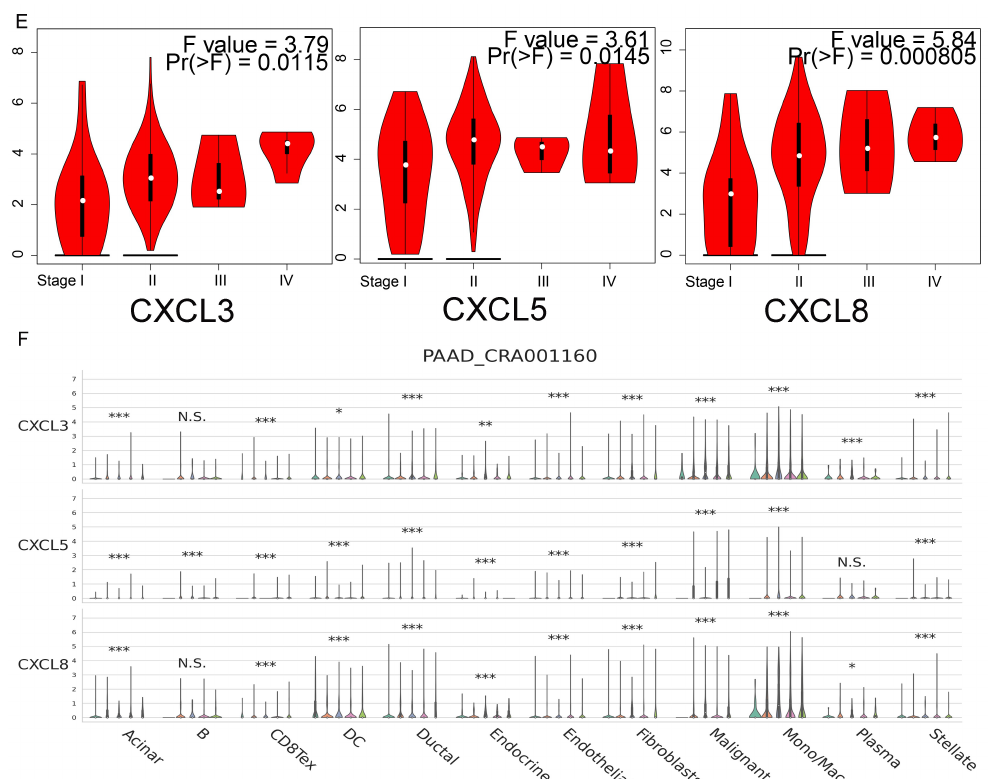
Figure 5. Correlation between CXC expression and tumor stage of BRCA ( A , B ), COAD ( C , D ), and PDAC ( E , F ) patients in GEPIA and TISCH.